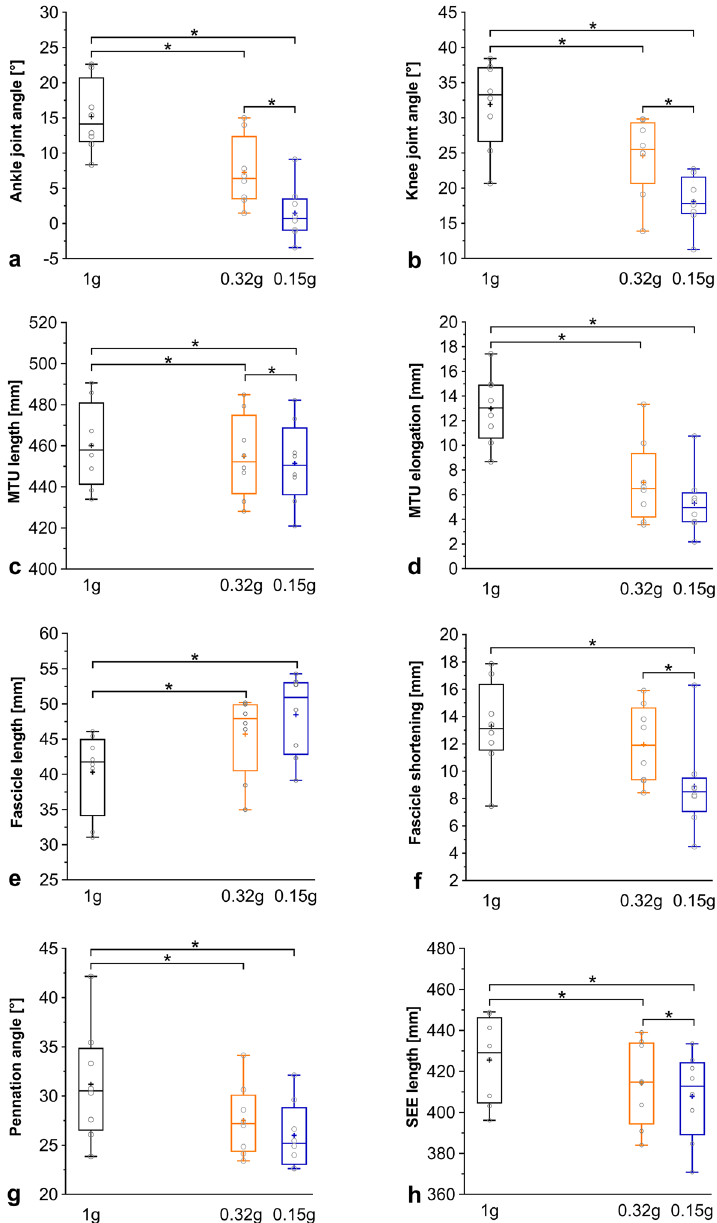
Figure 2. Gastrocnemius medialis fascicle and series elastic element behavior at the time of peak series elastic element length when running at 1 g, simulated Martian gravity, and simulated Lunar gravity. Ankle joint angle ( a ), knee joint angle ( b ), muscle ‒ tendon unit length ( c ), fascicle length ( e ), pennation angle ( g ) and series elastic element length ( h ) at the time of the peak series elastic element length as well as muscle ‒ tendon unit elongation ( d ) and fascicle shortening during series elastic element elongation ( f ) when running at 1 g (black box), 0.32 g (orange box) and 0.15 g (blue box). Please note that the observed hypogravity levels were slightly lower than the actual values for Martian and Lunar gravity. The lower and upper parts of the box represent the first and third quartile, respectively. The length of the whisker represents the minimum and maximum values. The horizontal line in the box represents the statistical median of the sample; + the mean of the sample; ○ individual data points; *significantly different (Tukey post-hoc, p ≤ 0.05). The boxplots of the 1 g condition in ( c , e , g , h ) have previously been published by Richter et al. 19 . n = 8